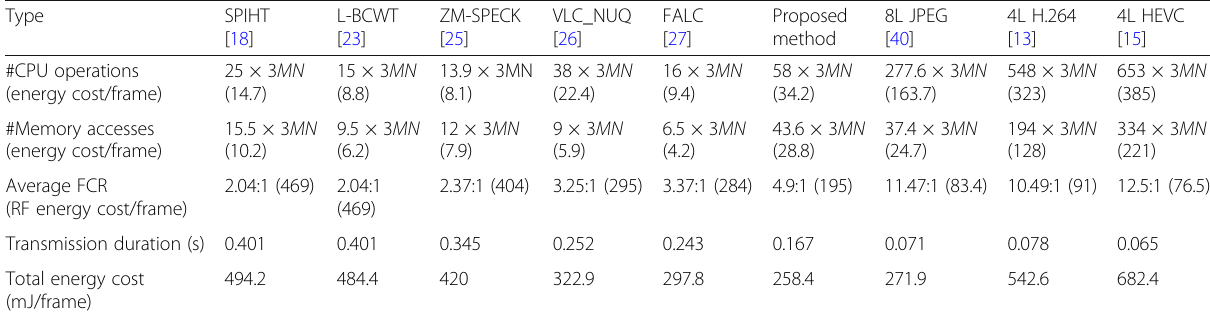
Table 4 Energy complexity of each compression algorithm (sum of microprocessor operation and memory accesses)